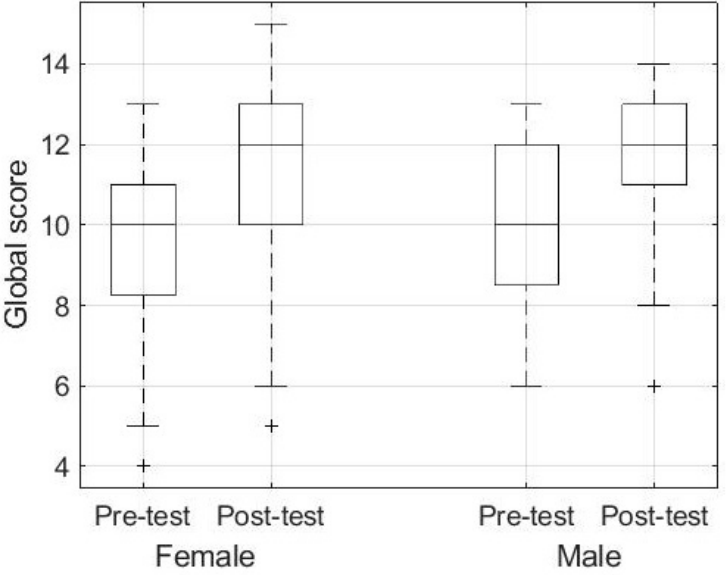
Figure 6. Global STAT score obtained by gender in the pre- and post-test.